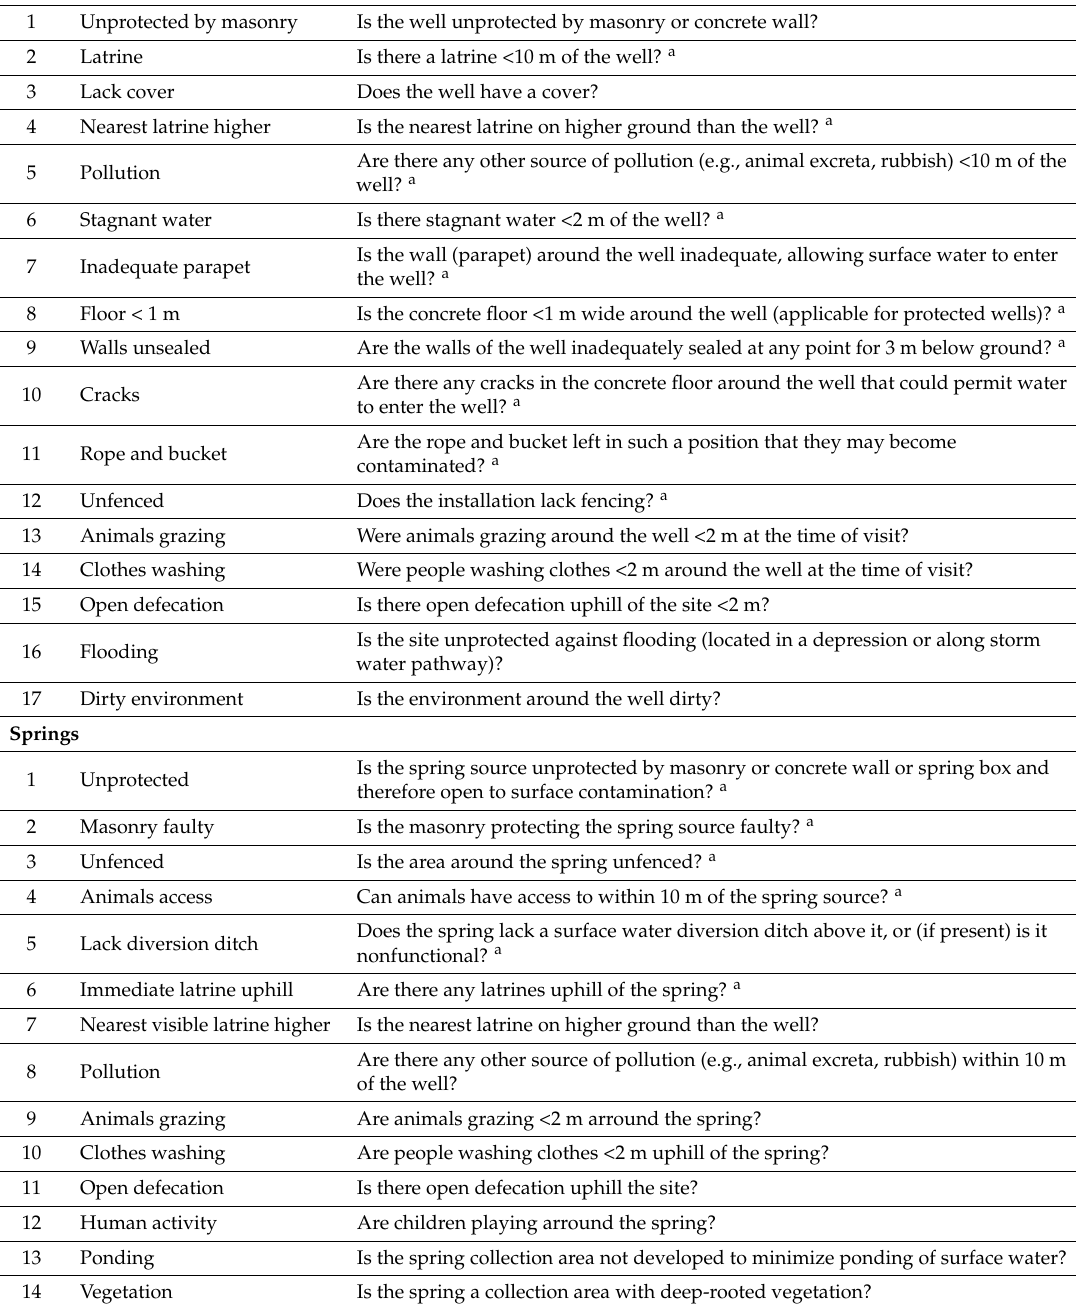
Table 1. Sanitary survey questions for springs, wells (covered dug well with hand-pump, dug well with windlass and partial cover, and open well), and rainwater adapted from the WHO Guidelines for Drinking Water Quality [8]. The factor present poses a risk; the factor not present means that risk factor does not